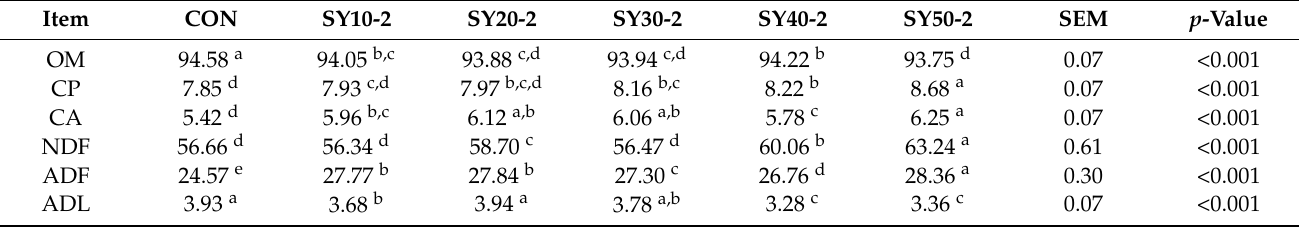
Table 2. Chemical compositions of the corn silages (% in DM).